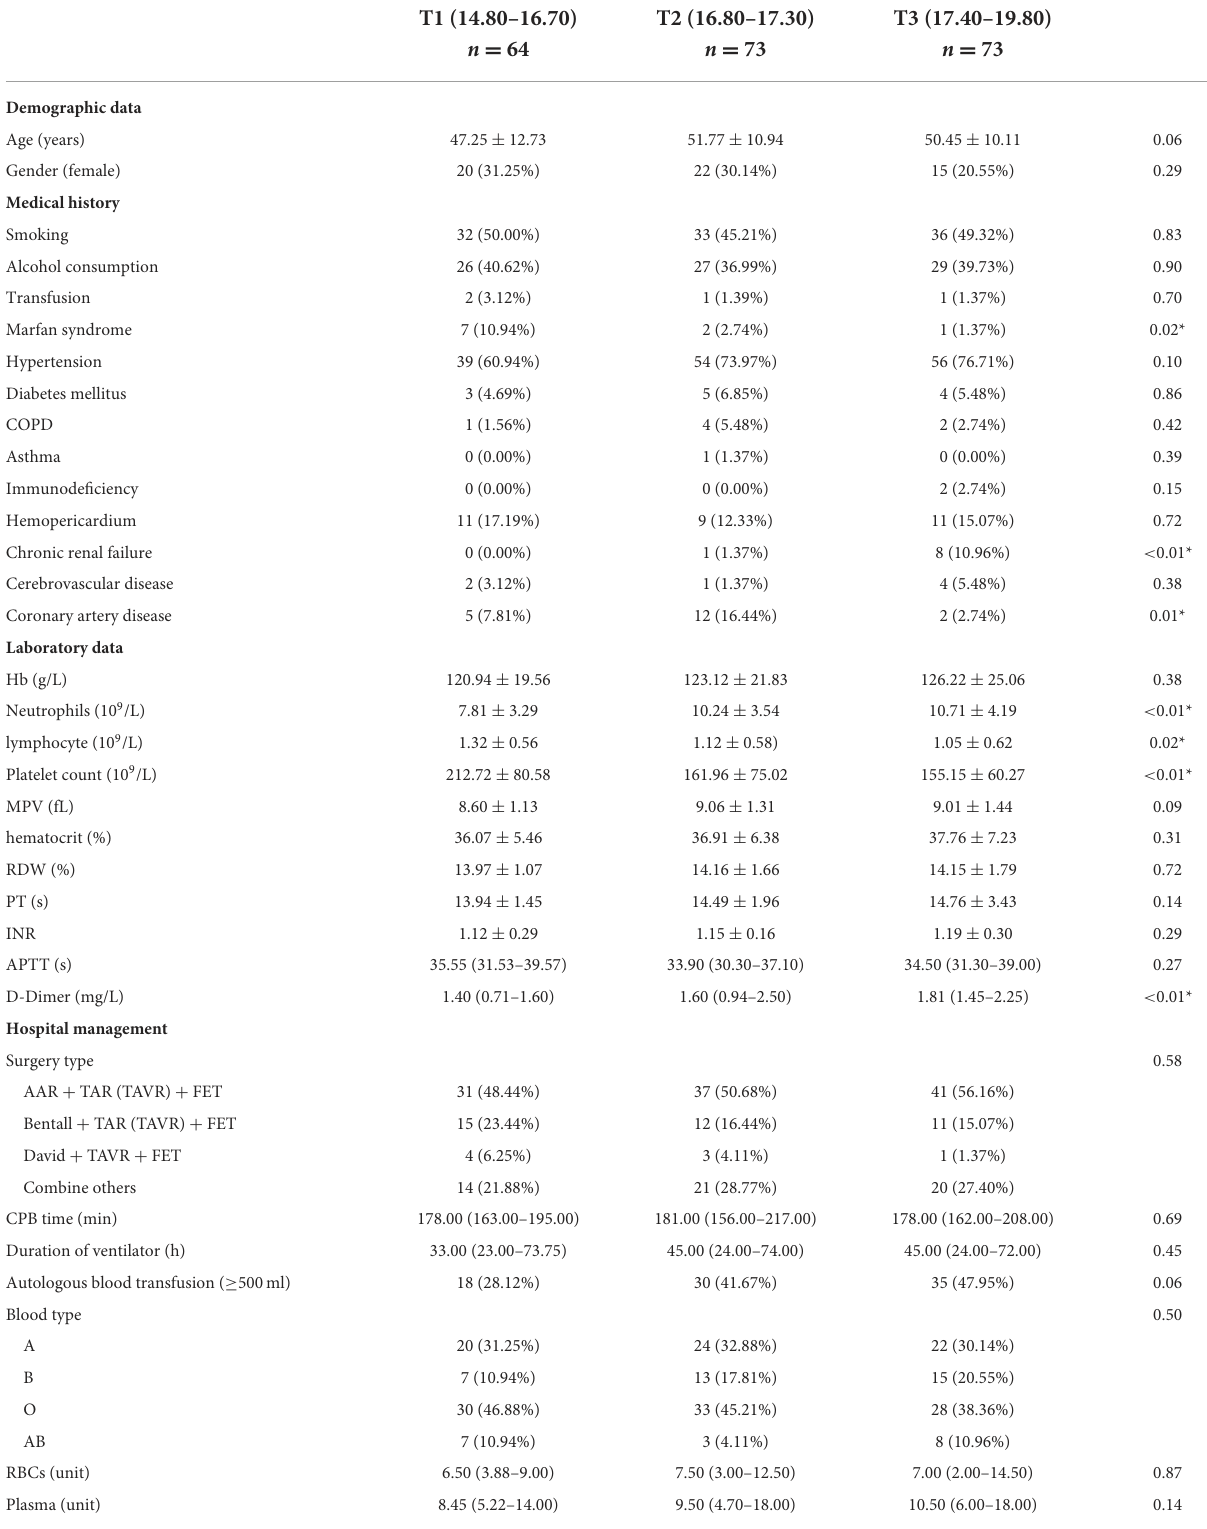
TABLE 1 Baseline characteristics of AAAD patients by PDW